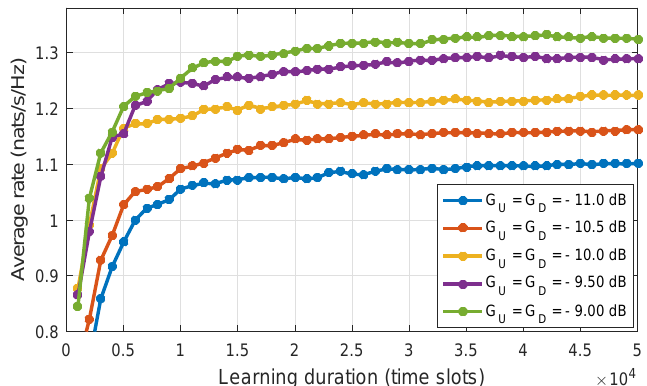
Figure 12. Convergence of the learning process for different mean values of channel